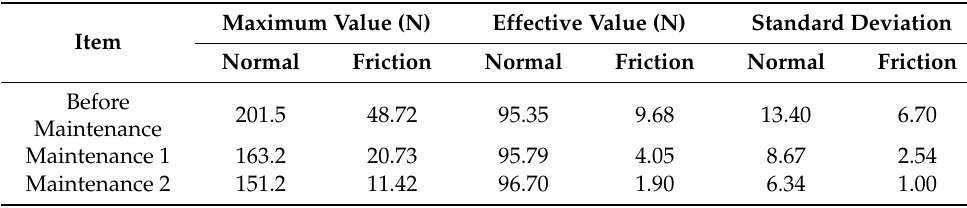
Table 4. Statistical values of the acceleration of pantograph